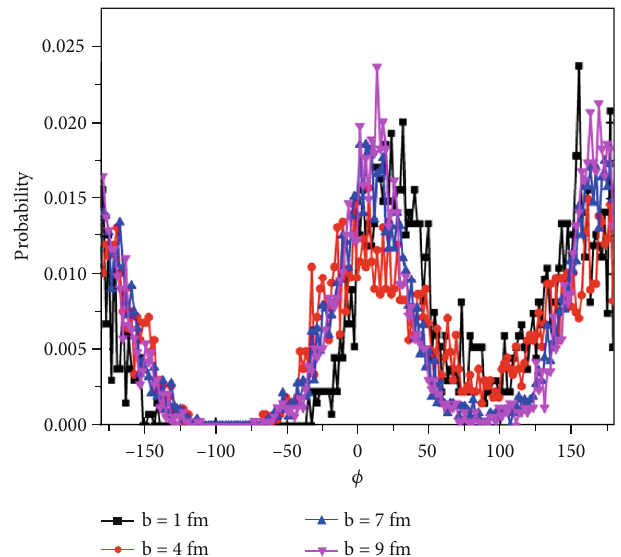
Figure 9: The dependence of angular distributions about ϕ on the impact parameter with respect to sequential ternary fi ssions in 197 Au + 197 Au system at an energy of beam axis, the separation axis (the fi rst separation), and the fi ssion axis (the second separation) by v ! ! − v ! ), respectively. The reaction plane is de fi ned by the ( v 1 2 beam and separation axes, and the normal direction n reaction plane is the unit vector of the cross product ð v ! Þ × v ! . The out-of-plane angle θ speci fi es the de fl ection v 3 cm